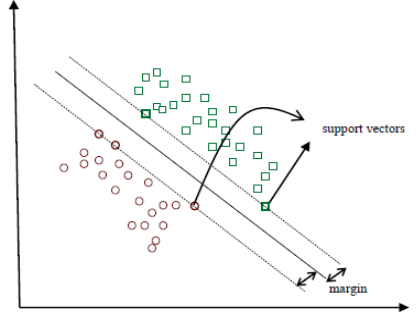
Figure 1. Basic concept of SVM [39].